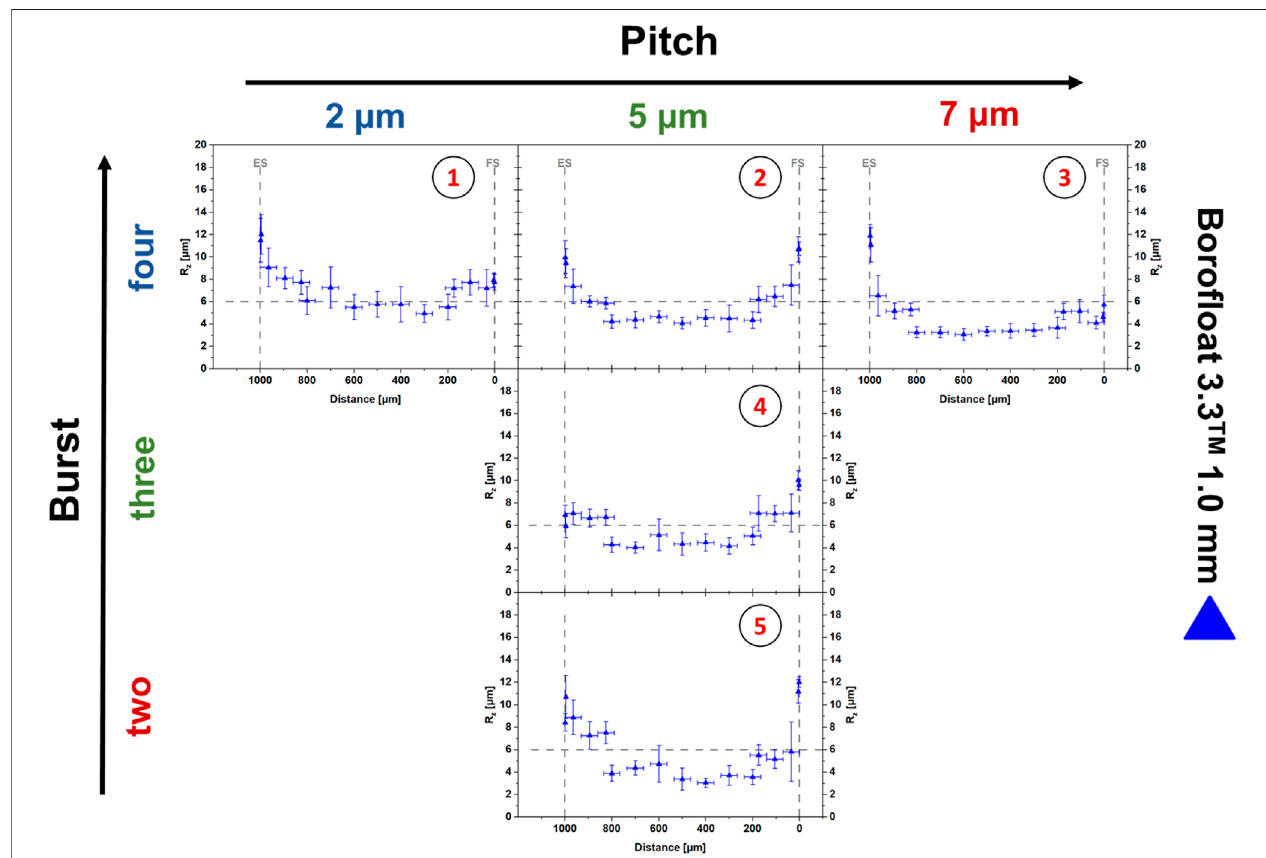
FIGURE 8 | Maximum roughness R z pro fi les along the cross section for the Boro fl oat 3.3 ™ 1.0 mm series. Gray dashed lines are guide to the eye, i.e., horizontal line fi xedat6 µmandmarkEntry-andFocus-Side(vertical).IncreasedroughnessattheEntry-andFocusSidecanbeseenwhilethemiddleareasremainatlowervalues.